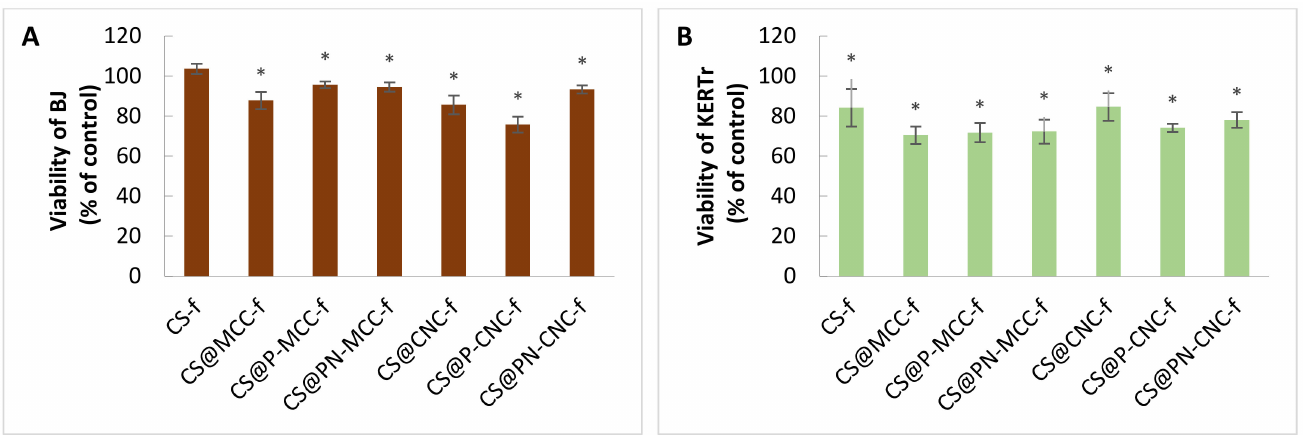
Figure 4. Viability of BJ ( A ) and KERTr ( B ) treated with chitosan-cellulose biocomposites for a 24 h incubation period, n = 6. * p <